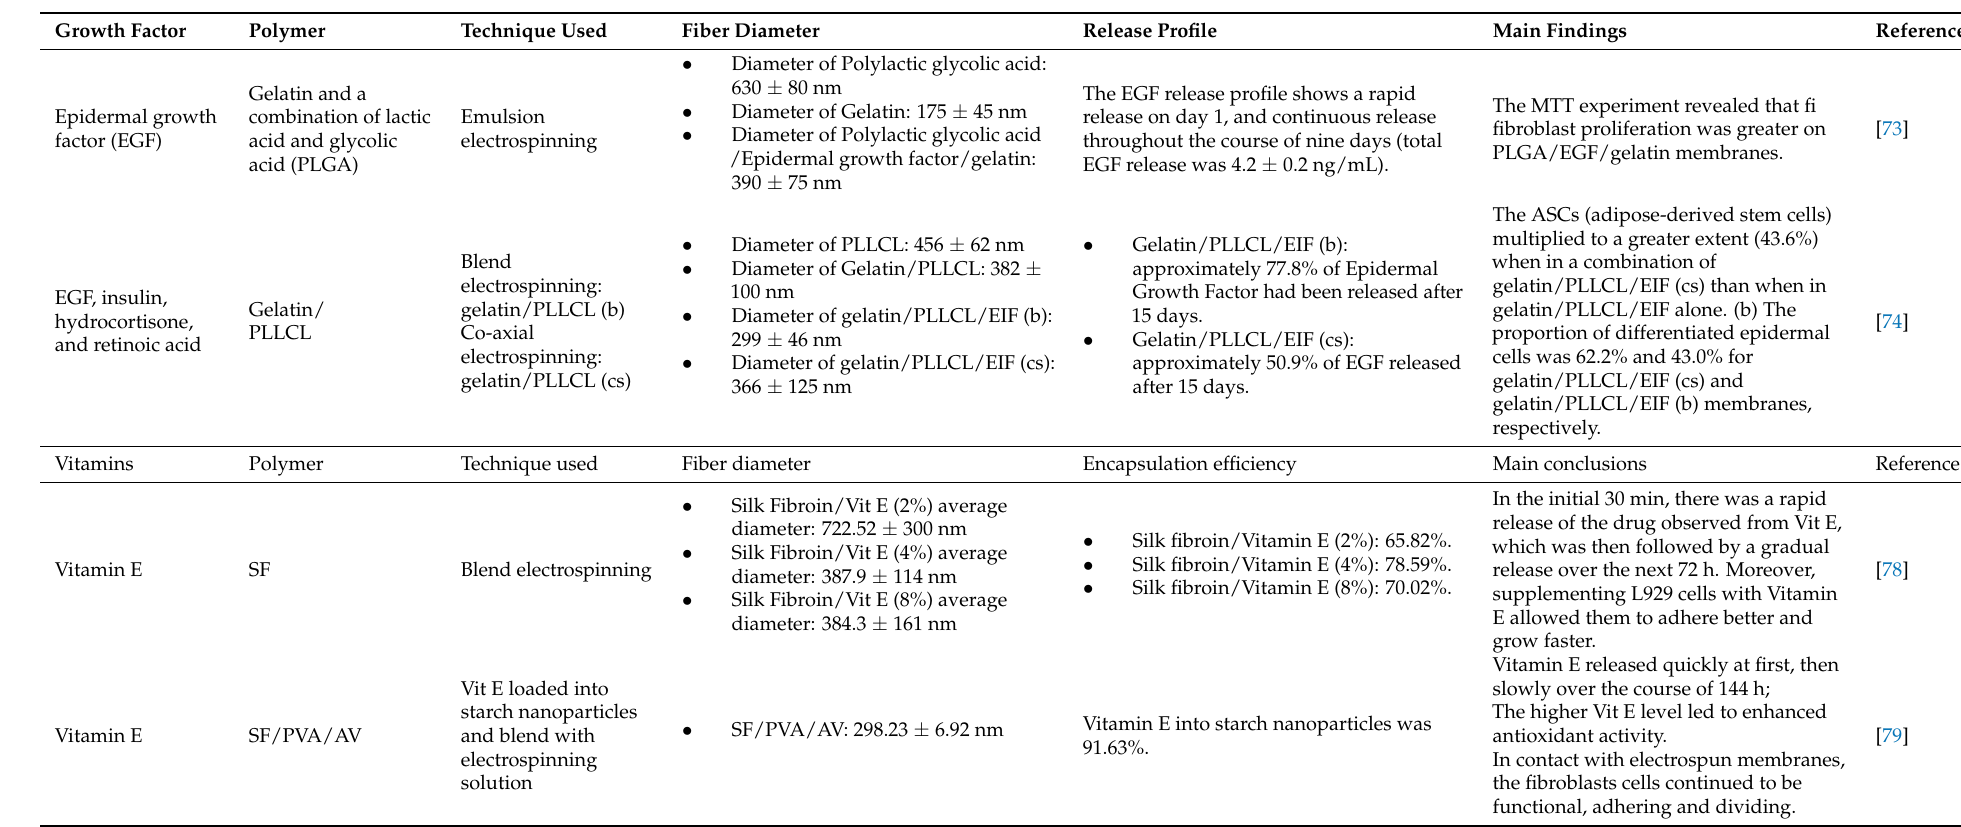
Table 3. List of different growth hormones, vitamins, and anti-inflammatory agents that can be integrated into electrospun fabrics for treating